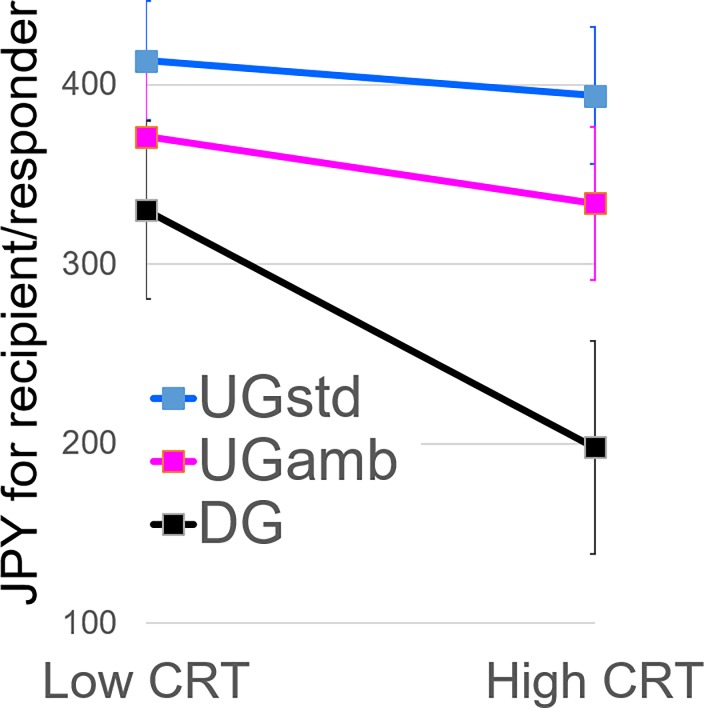
The levels of giving in the DG, the UGSTD, and the UGAMB as a function of the categorized CRT.Error bars represent 95% confidence intervals in the relevant within-participant condition.